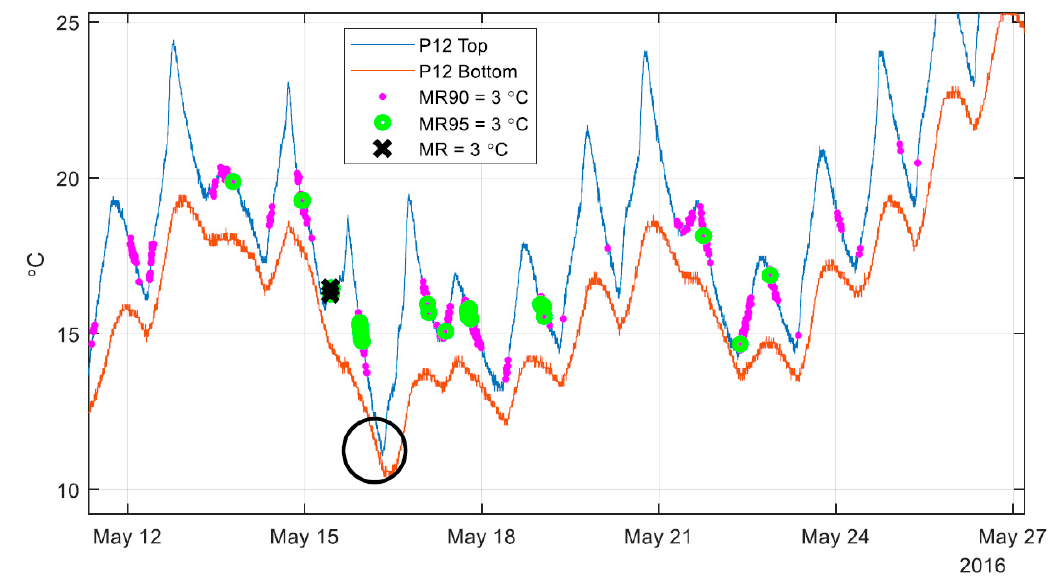
Figure 9. Points considered as having minimal gradients, observed using MR methods.